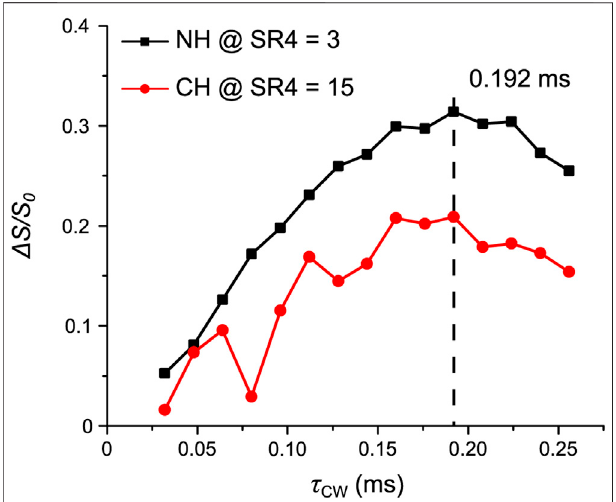
FIGURE8| AcAla:thesignalfraction Δ S / S of 0.19 ms and C H (red circles) at τ mix of 0.96 ms as a function of τ CW . The optimum τ CW is shown and highlighted by the dashed line. Further experimental details are given in the Experiments